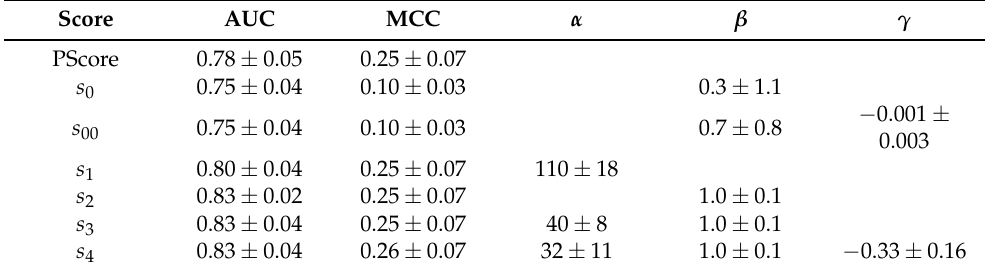
Table 4. Typical values of AUC and MCC on the test set using PP as the positive set and hsnLLPS as the negative set. The optimised parameters α , β and γ are also summarised here ( ˜ β and ˜ γ are actually reported for scores s 0 and s 00 ). The numerical entries are the mean or the median (depending on whether the quantity follows a normal distribution or not, respectively, see File S1) ± the standard deviation of the corresponding